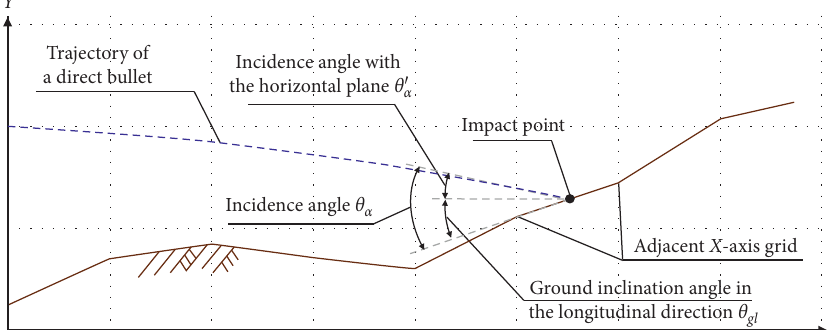
Figure 4: Calculation of incidence angle at the point of impact.